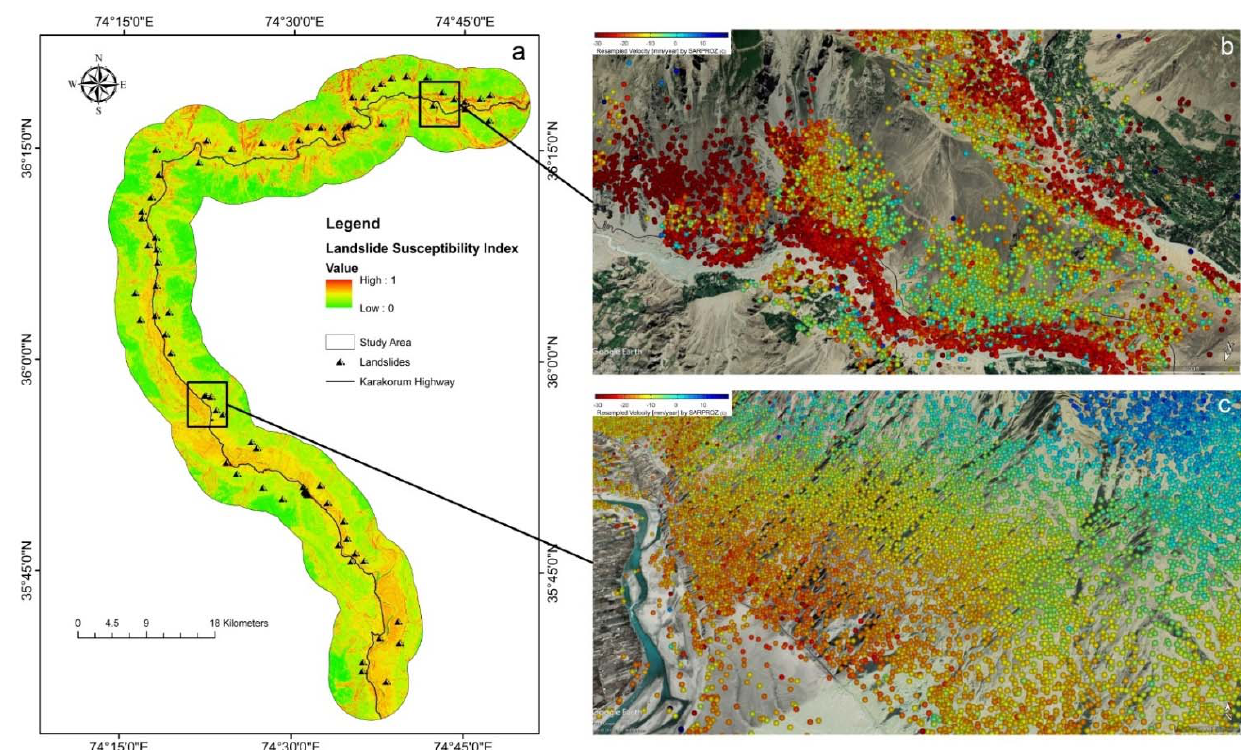
Figure 12. PSI spatial distribution of LOS deformation velocities on Google Earth images: ( a ) landslide susceptibility index map, ( b ) a zoomed view of LOS velocities near Karimabad area, ( c ) deformation velocities in a magnified view near Gilgit area.